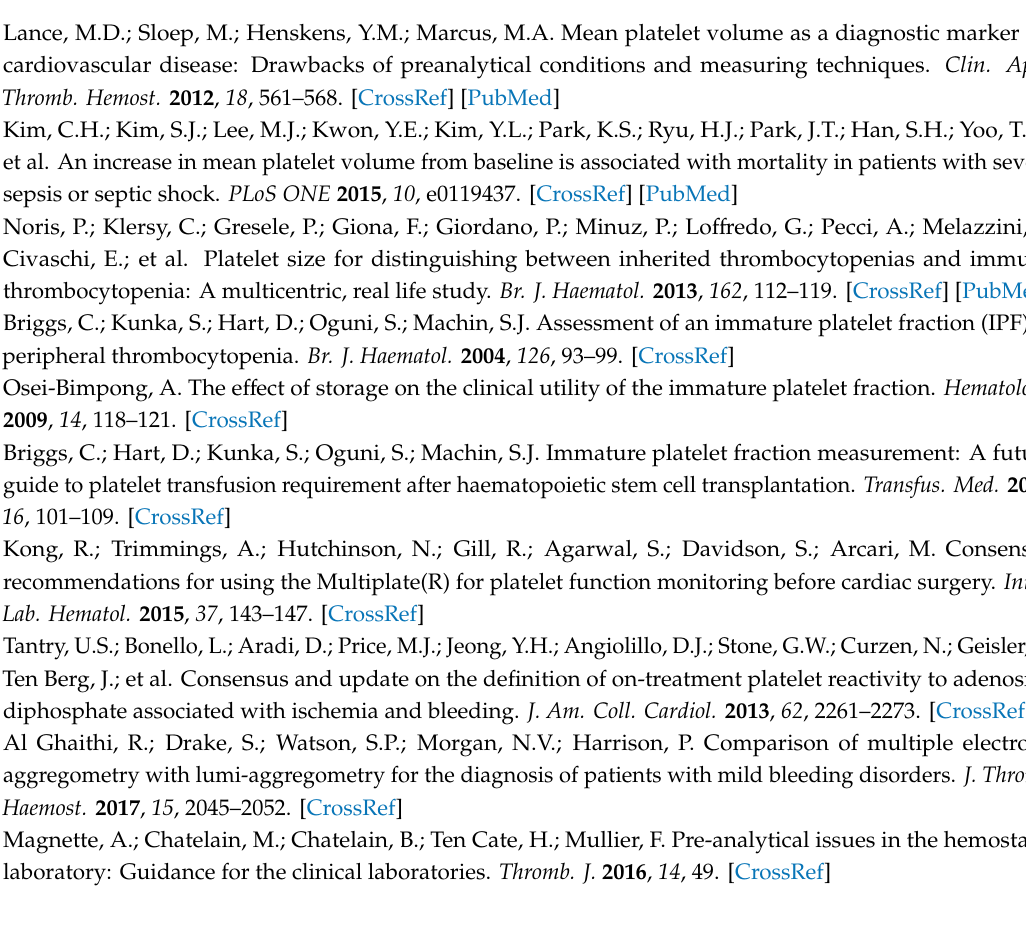
Figure S1: Changes in platelet count over time between blood draw and analysis, Figure S2: Changes in mean platelet volume and of immature platelet fraction over time between blood draw and analysis for each anticoagulant, Figure S3: Changes in platelet function (assessed by MEA) over time elapsed between blood draw and analysis, Figure S4: Percentage of platelets within clumps over time for each anticoagulant, Table S1: Comparison of the mean di ff erences in platelet counts at the five time points, Table S2: Comparison of the mean di ff erences in platelet counts between the anticoagulants at the five time-points, Table S3: E ff ect of the method of measurement on platelet count for each anticoagulant, Table S4: Comparison of the e ff ect of the anticoagulants on MPV measurement at the five time-points, Table S5: Comparison of the e ff ect of the anticoagulants on IPF measurement at the five